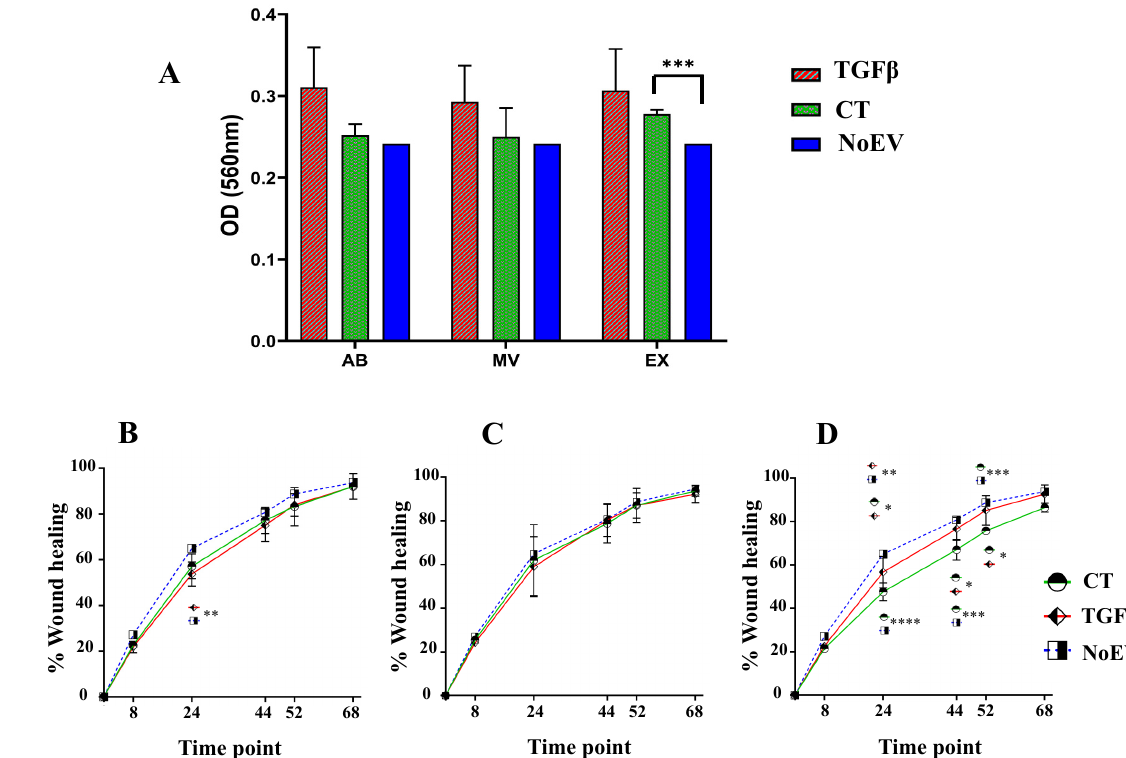
Figure 3. Induction of fibroblast proliferation and migration by EVs from TGF β -stimulated UCMSCs and normal UCMSCs. ( A ) A higher capacity of EXs derived from normal UCMSCs to induce dermal fibroblast proliferation compared to the negative control (NoEV). ( B ) AB population from the NoEV group stimulated fibroblast migration faster to close wounds compared to ABs from TGF β -stimulated UCMSCs at 24 h. ( C ) MVs from all three groups did not show any difference in inducing fibroblast migration at all time points. ( D ) Different capacity of EXs to stimulate fibroblast migration: the strongest induction belonged to NoEV group, followed by the EXs from TGF β -stimulated UCMSC. CT: control group (UCMSCs cultured in normal condition), TGF β : TGF β -stimulated UCMSC group, NoEV: EV-depleted cell culture media, AB: apoptotic body, MV: microvesicle, EX: exosome. N = 3, * indicates p < 0.05, ** indicates p < 0.01, *** indicates p < 0.001, **** indicates p < 0.0001.